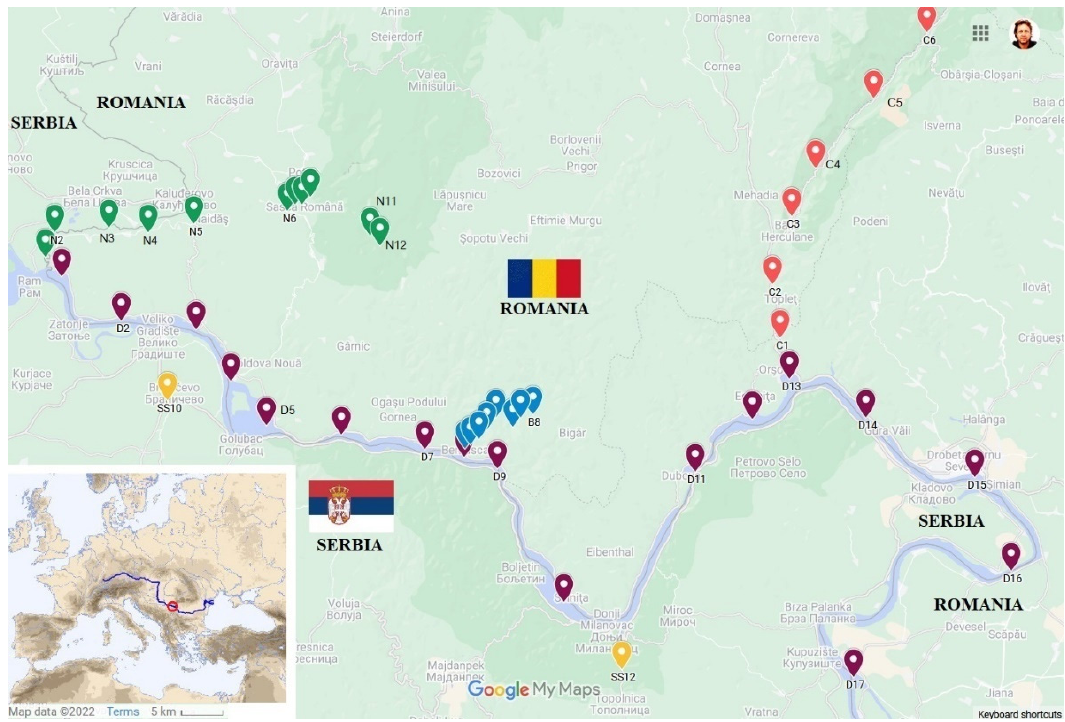
Figure 1. Sampling points for sediments and surface water quality analysis on Danube.